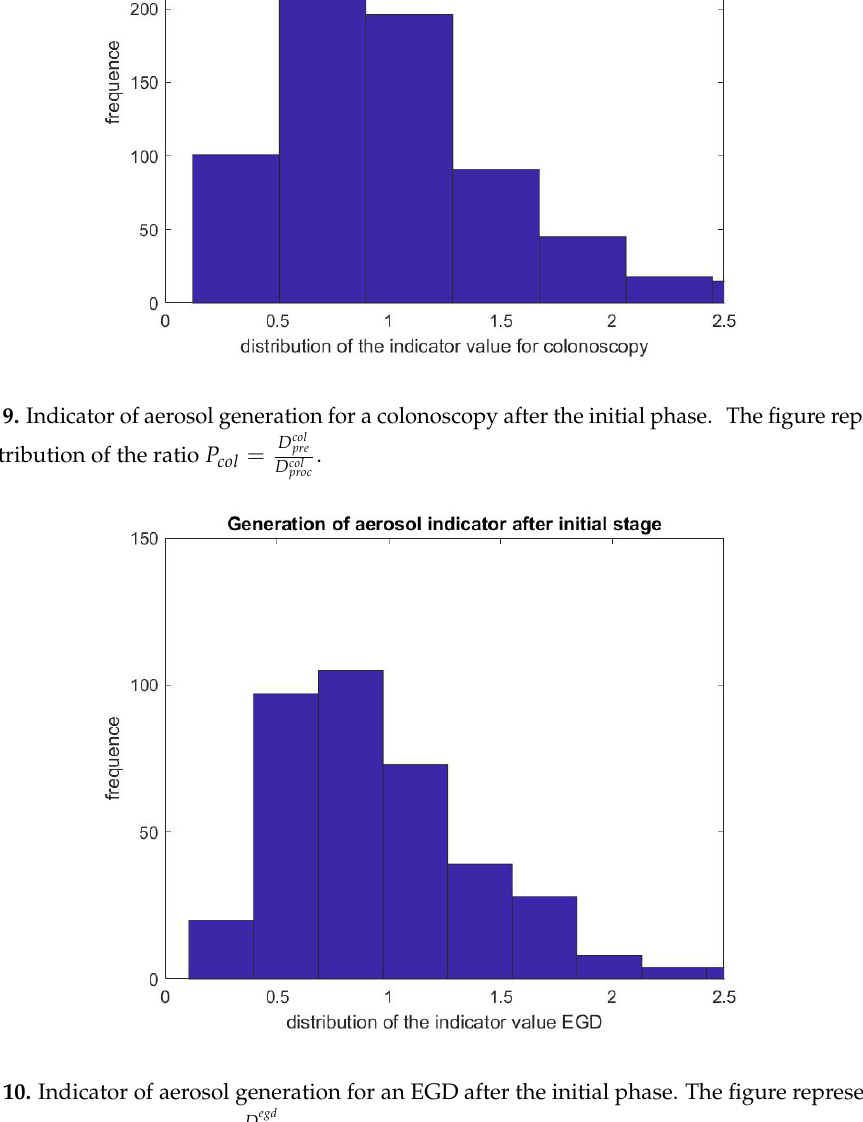
egd pre D egd proc